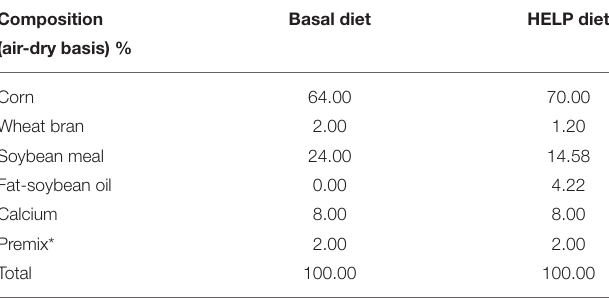
TABLE 1 | Composition of the basal diet and HELP